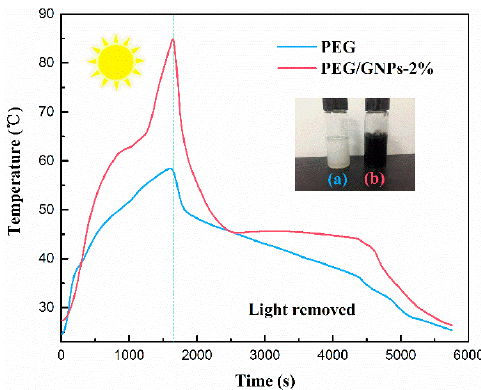
Figure 10. The variation in temperature with irradiation time of pure PEG and PEG/GNPs-2% composite.